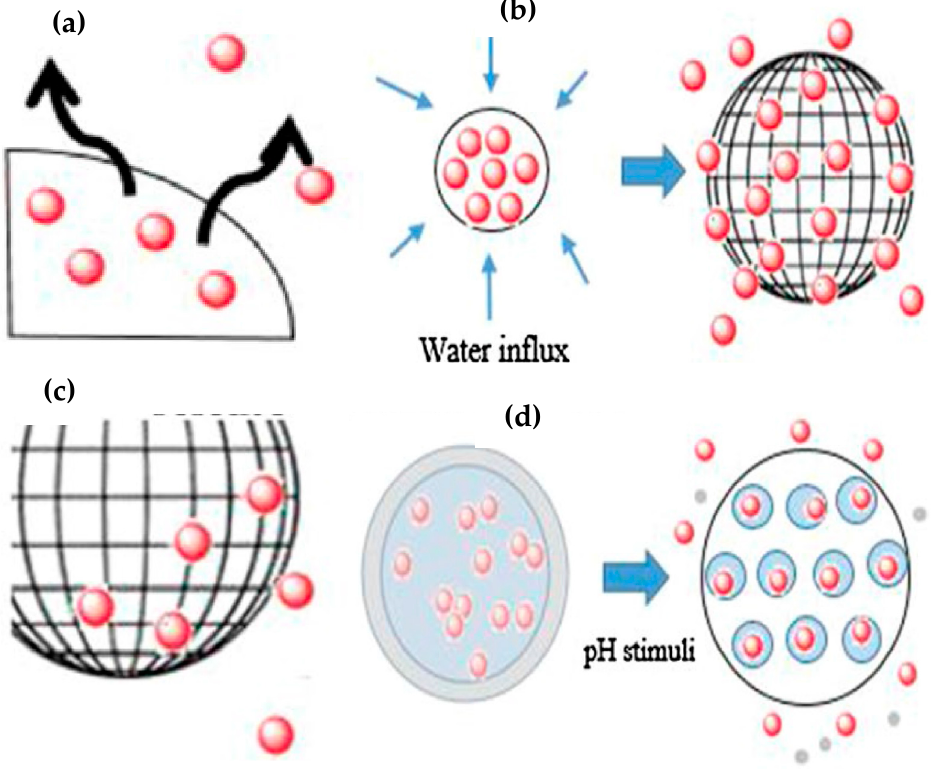
Figure 2. Different drug release mechanisms from nano-carriers have been presented schematically: ( a ) Diffusion-controlled; ( b ) solvent-controlled; (c) polymer-degraded; ( d ) pH-sensitive; (from Son et al. [69]); Reprinted with permission from [69]. Copyright 2017 Springer.